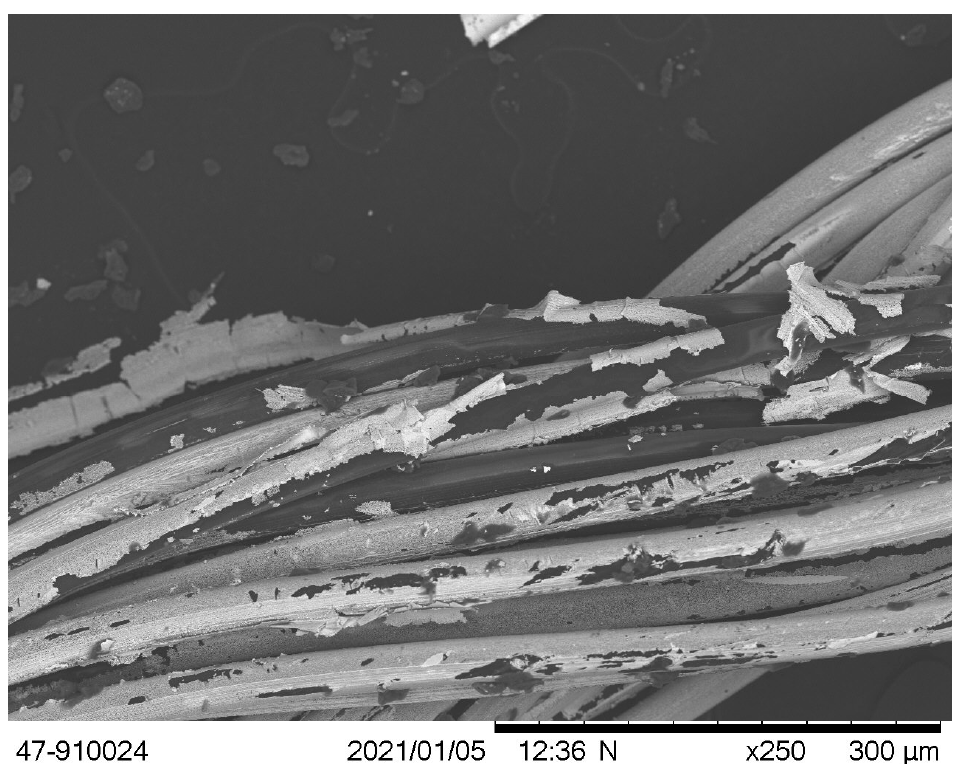
Figure 7. SEM image of a healthy Silver-Tech 120 sample, with obvious severe de-plating of the silver conductive layer.